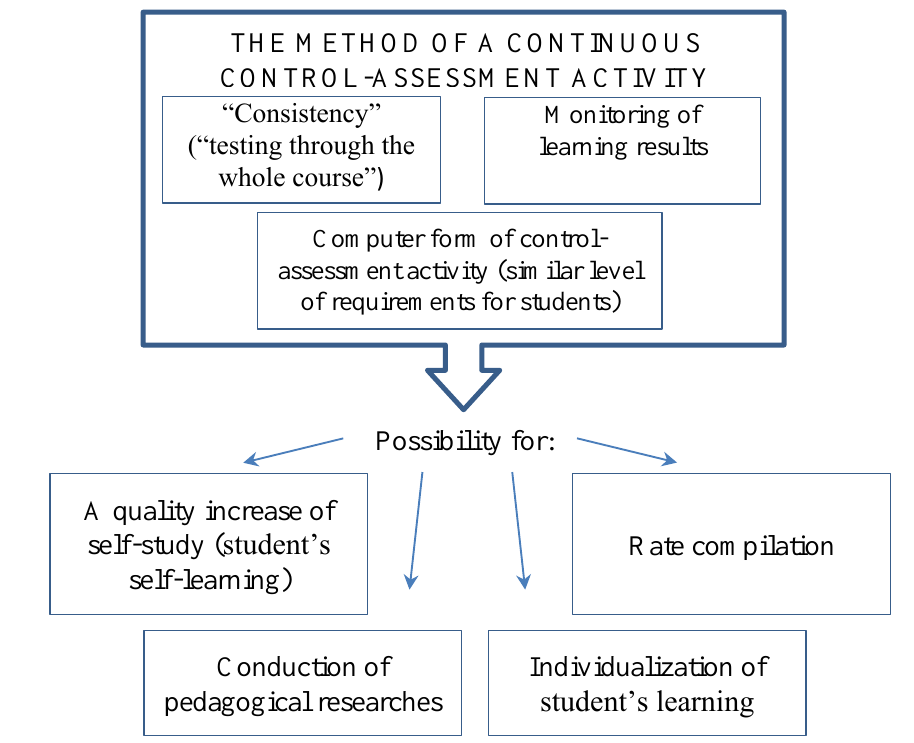
Fig. 2. The method of a continuous control-assessment